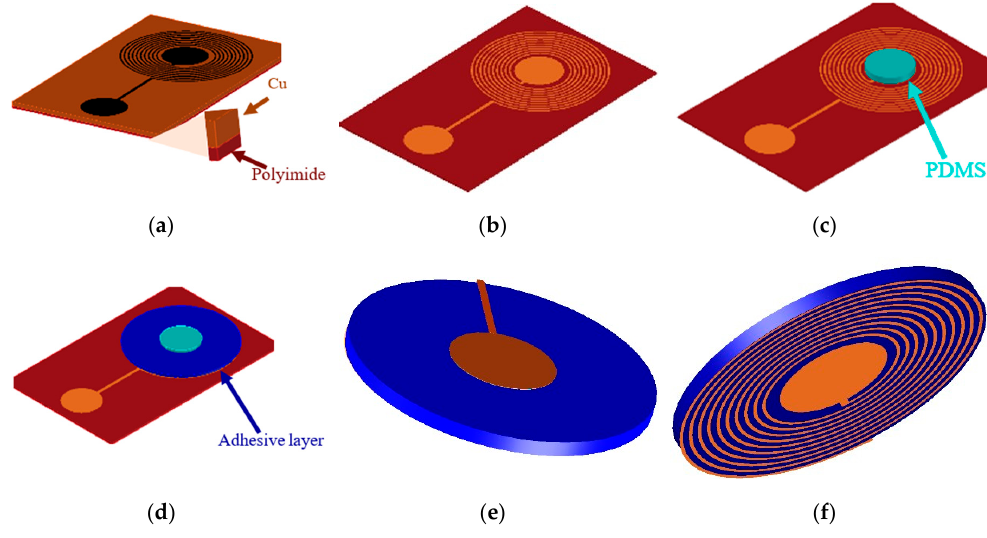
Figure 4. Fabrication process: ( a ) Copper-coated polyimide film with ink printed mask. ( b ) Etched pattern showing capacitor electrodes and planar inductor spirals. ( c ) Dielectric layer of PDMS elastomer. ( d ) Adhesive layer placement around the PDMS dielectric. ( e ) Top view and ( f ) bottom view of the LC sensor.